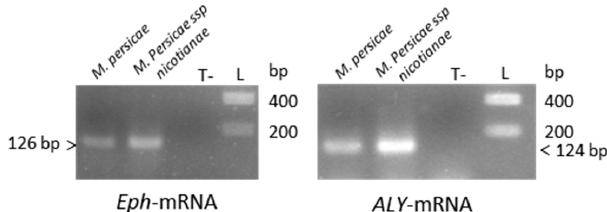
Figure 1. Detection of ALY - and Eph -mRNA in M. persicae (Sulzer) or in M. persicae ssp. nicotianae by reverse transcription polymerase chain reaction (RT-PCR; Supplementary Materials Table S1). PCR